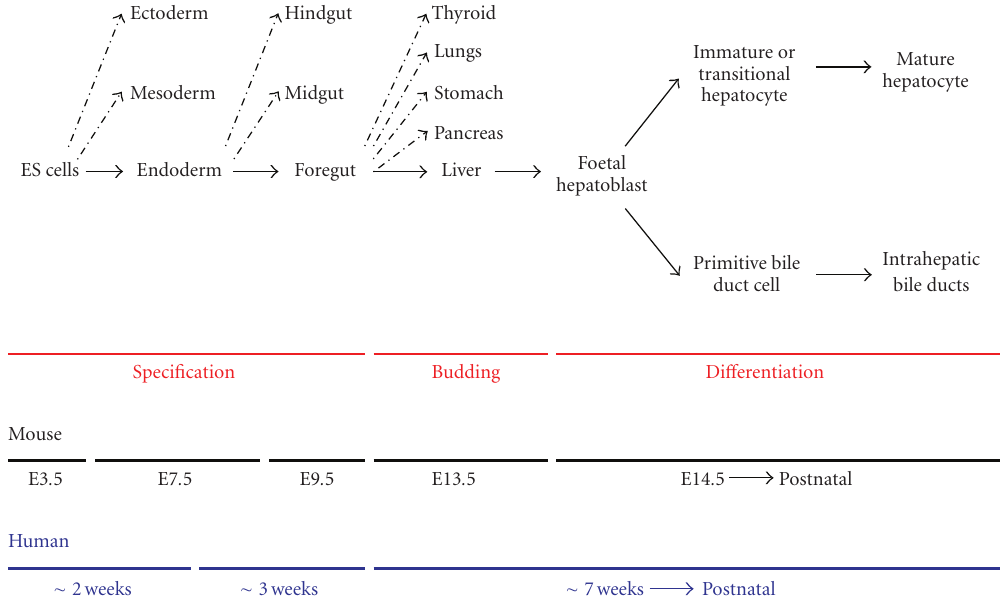
Figure 1: The lineage of the developing liver in vivo. Pluripotent embryonic stem (ES) cells from the blastocyst inner cell mass give rise to three principal germ layers: ectoderm, mesoderm, and endoderm. The anterior region of the endoderm will form the foregut. Following hepatic specification of foregut endoderm, hepatic cells (now called hepatoblasts) will bud into the septum transversum and continue to proliferate and di ff erentiate. Maturation into hepatocytes and bile epithelial cells continue until several weeks after birth. The red bars highlight the key stages of liver development. The black bars in the middle are mouse embryos at di ff erent stages of development, and the blue bars at the bottom indicate the equivalent stages in human